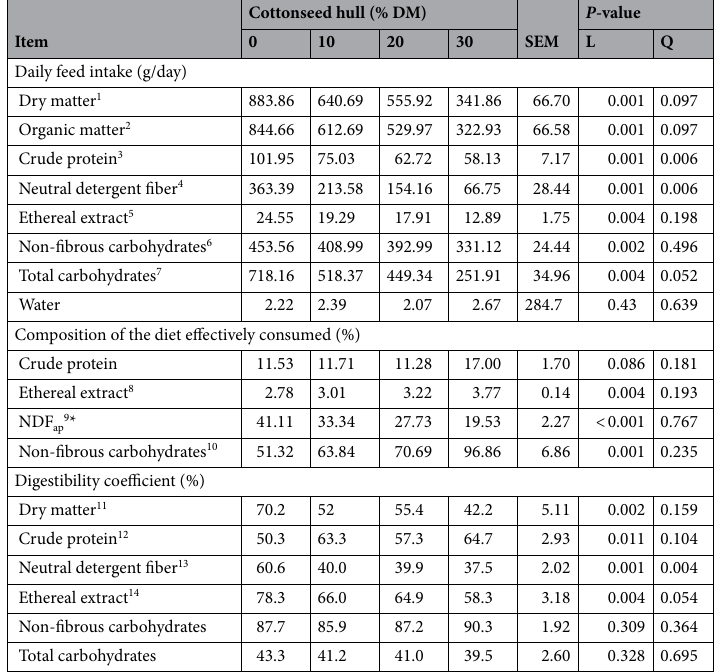
Table 1. Feed intake and apparent digestibility coefficient of rams fed different levels of cottonseed hull. *Neutral detergent fiber corrected for ash and protein. 1 Y = 862.202 − 17.107X; 2 Y = 824.759 −